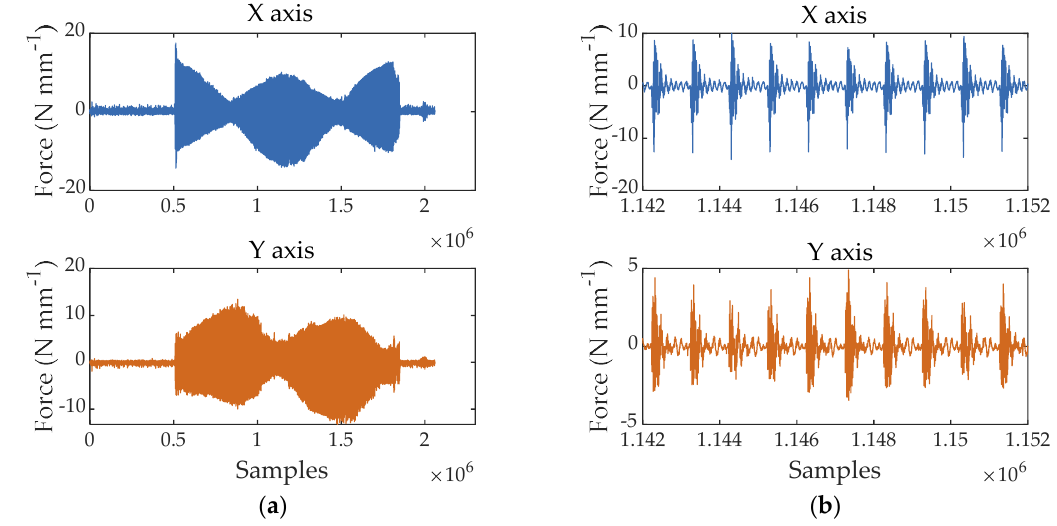
Figure 4. Rough cutting forces measured by the dynamometer X- and Y-axes when up-milling a PTFE disk with a depth of cut of 1.5 mm: ( a ) full signals; ( b ) same signals magnified over 10 tool revolutions. The forces are normalized by the sample thickness.